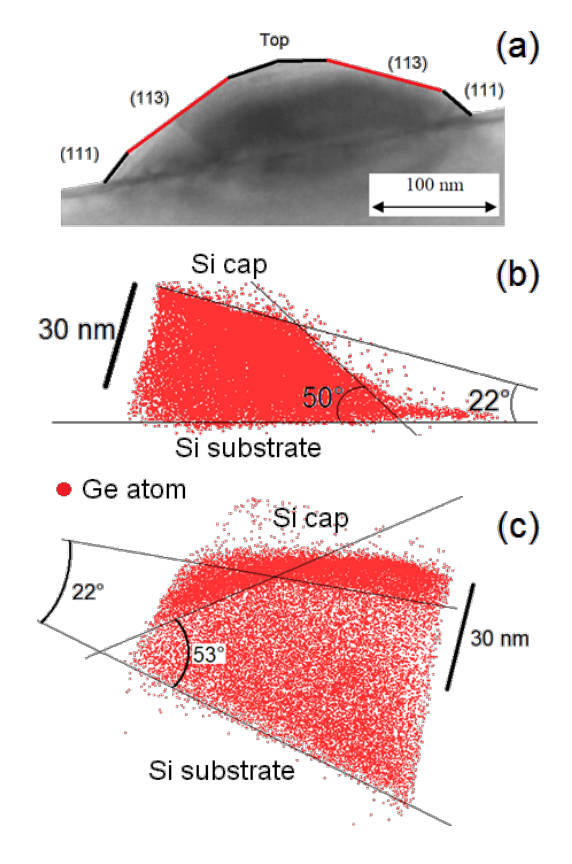
Figure 5: Cross-sectional TEM image of a typical dome island (a), and side-views of two different APT volumes showing only the Ge atoms they contain (b and c).